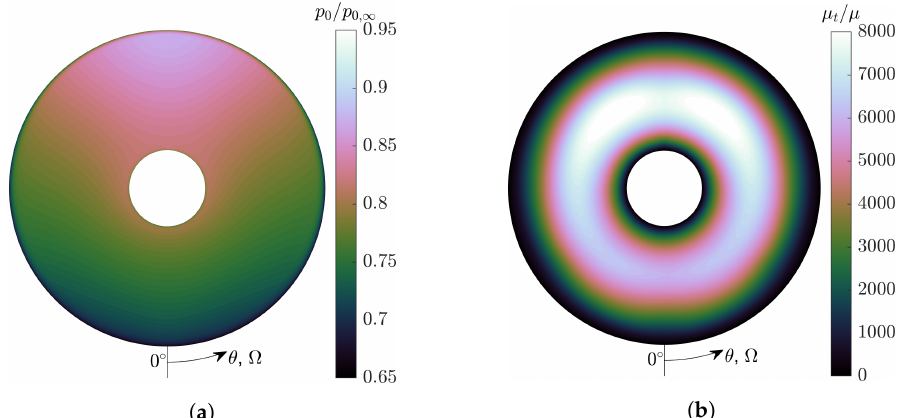
Figure 14. Propulsor inlet distortion, case I. ( a ) Total pressure distribution p 0 / p 0, ∞ . ( b ) Turbulent viscosity ratio µ t / µ